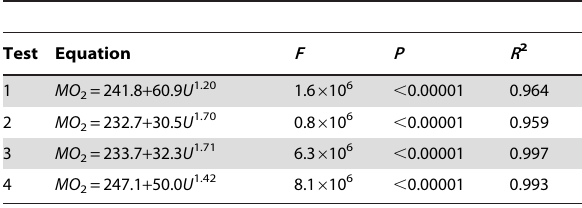
Table 2. Relationship between oxygen consumption rate and swimming